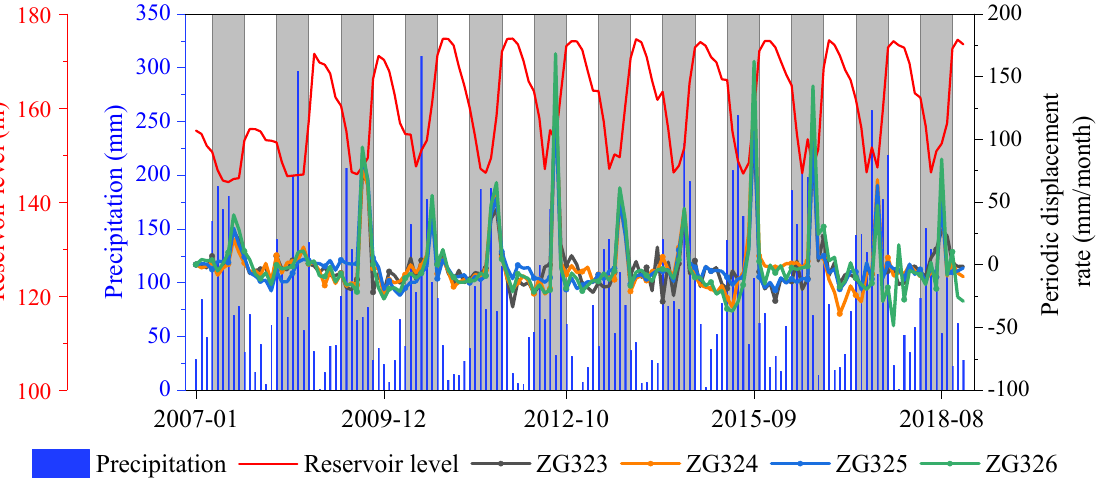
Figure 9. Precipitation, reservoir level, and periodic displacement rate in ZG323 to ZG326. White fill—dry season; gray fill—rainy season.